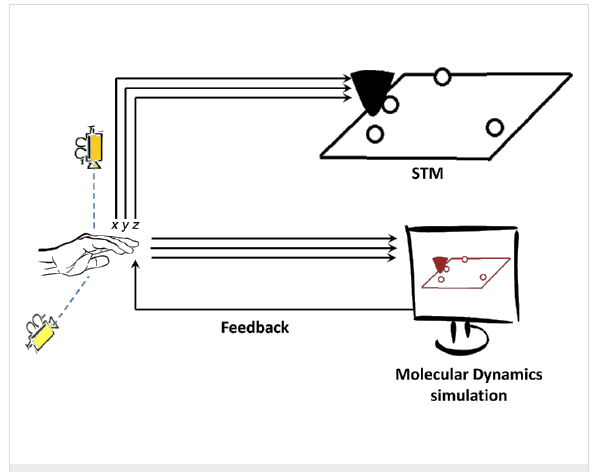
Figure 1: Schematic of the experimental setup. The components of the setup include a cryogenic UHV STM, a 3D motion controller and a MD simulator. The motion tracker controls both the STM and the MD